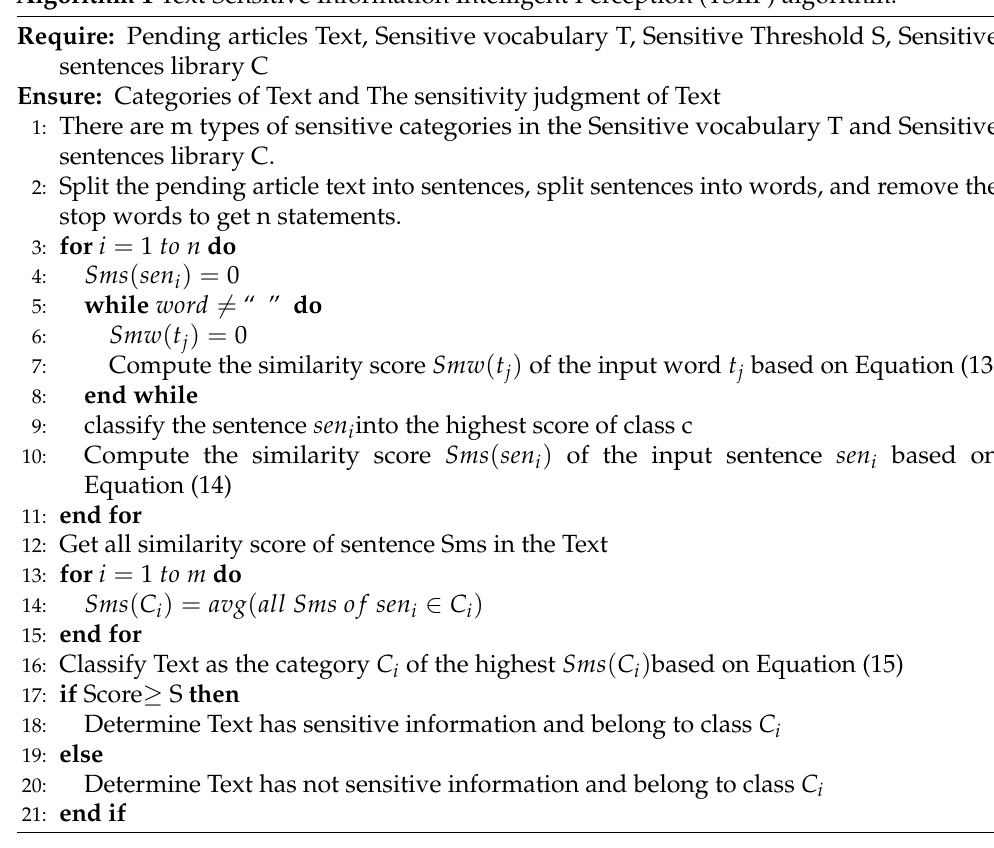
Algorithm 1 Text Sensitive Information Intelligent Perception (TSIIP)